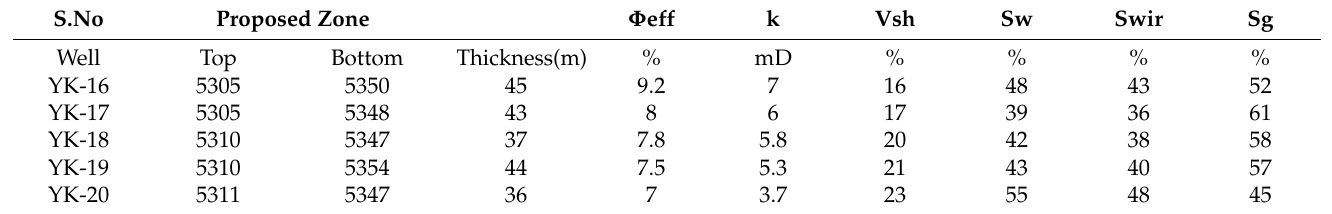
Table 2. Summary of petrophysical estimates (Ave) in proposed zones of the Yageliemu clastic